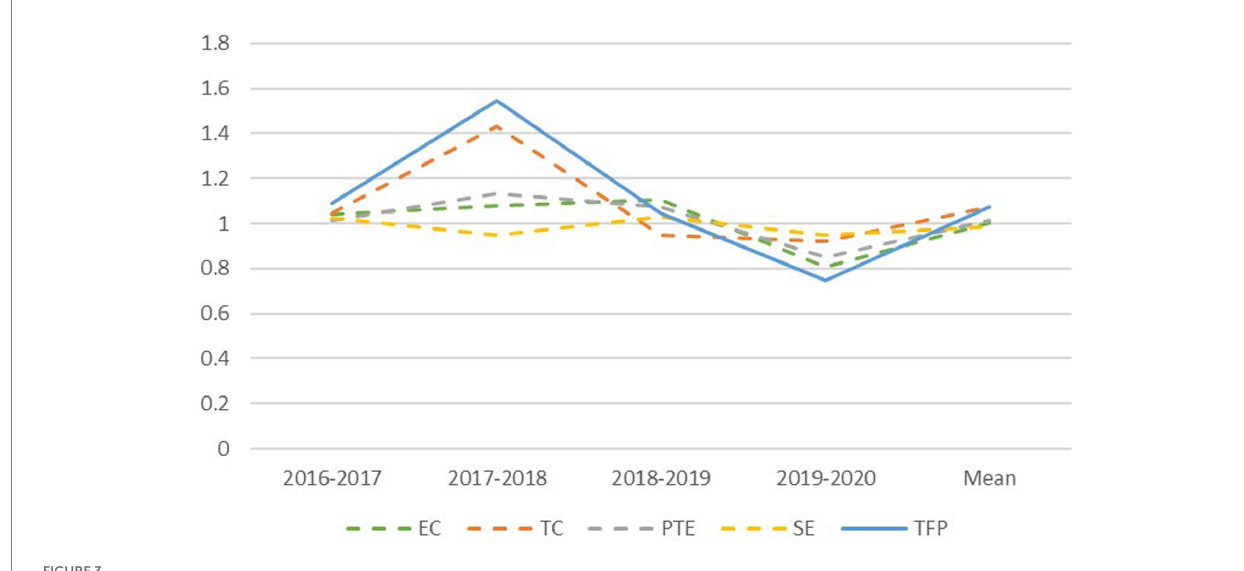
FIGURE 3 Change trend of annual average of Malmquist index.